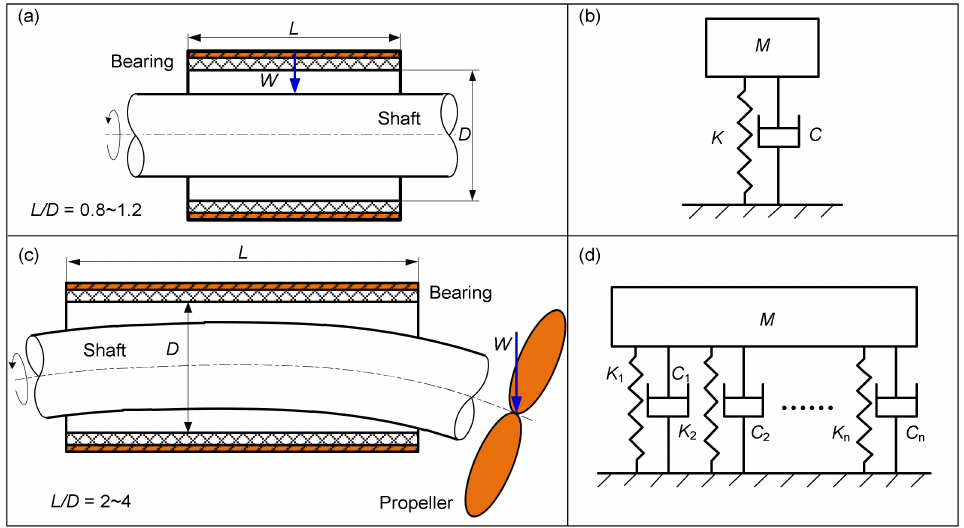
Figure 1. Two kinds of structure and dynamic models of journal bearings: ( a ) structure of common journal bearing; ( b ) dynamic model of common journal bearing; ( c ) structure of large-aspect-ratio journal bearing; ( d ) dynamic model of large-aspect-ratio journal